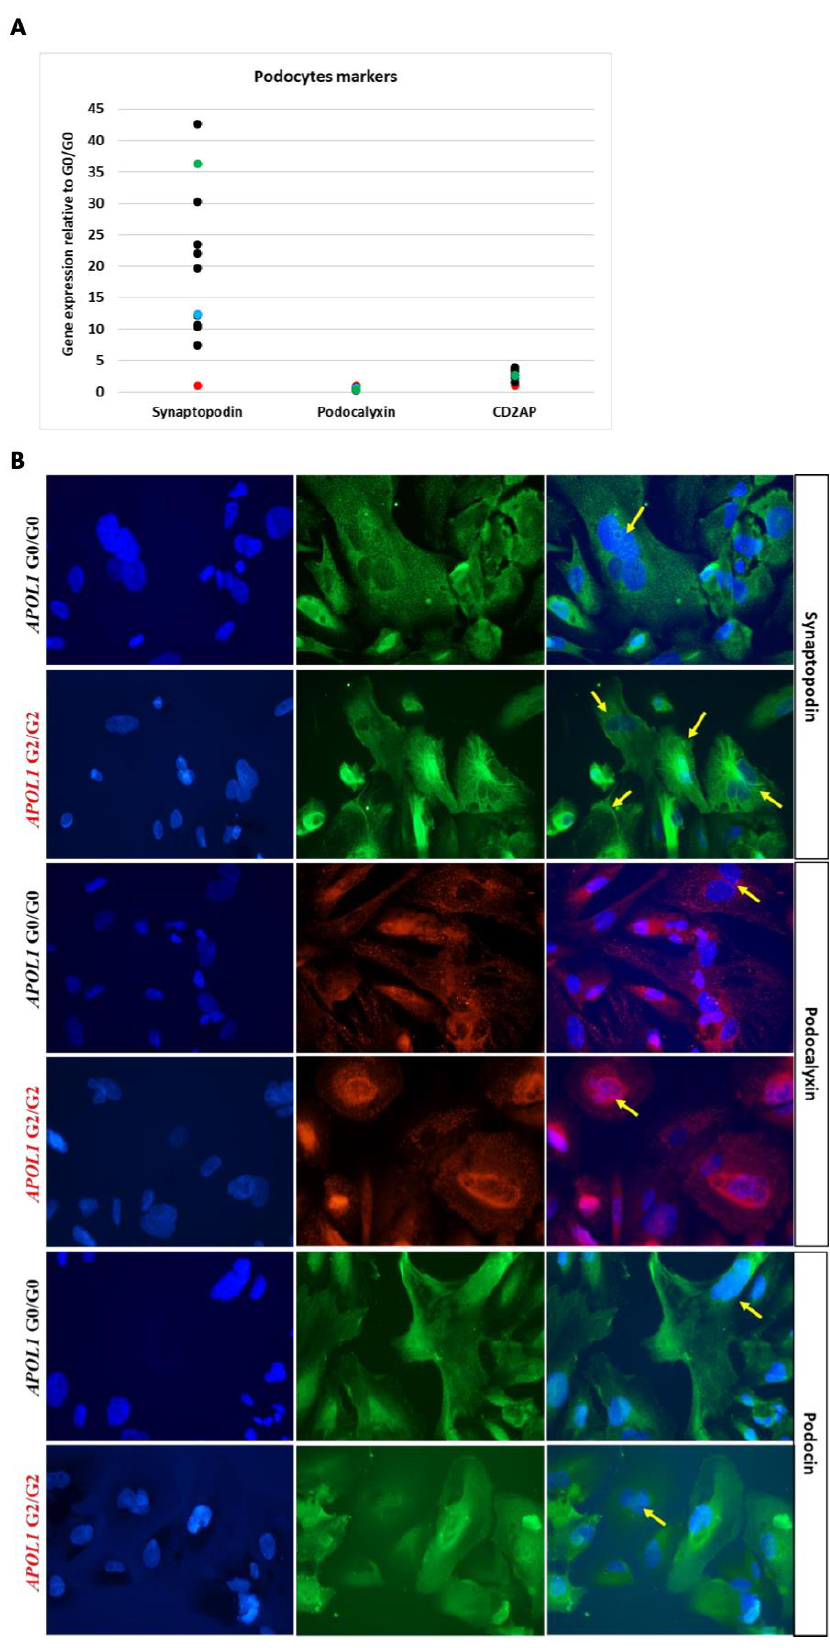
Figure 1. Characterisation of human podocytes obtained from urine of the donor carrying